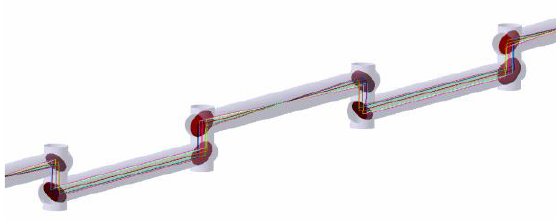
Fig. 2. 3D CAD model of MBTL basic concept, composed by 8 reflecting mirrors (4 focusing and 4 flat mirrors) with 90 ◦ reflections.